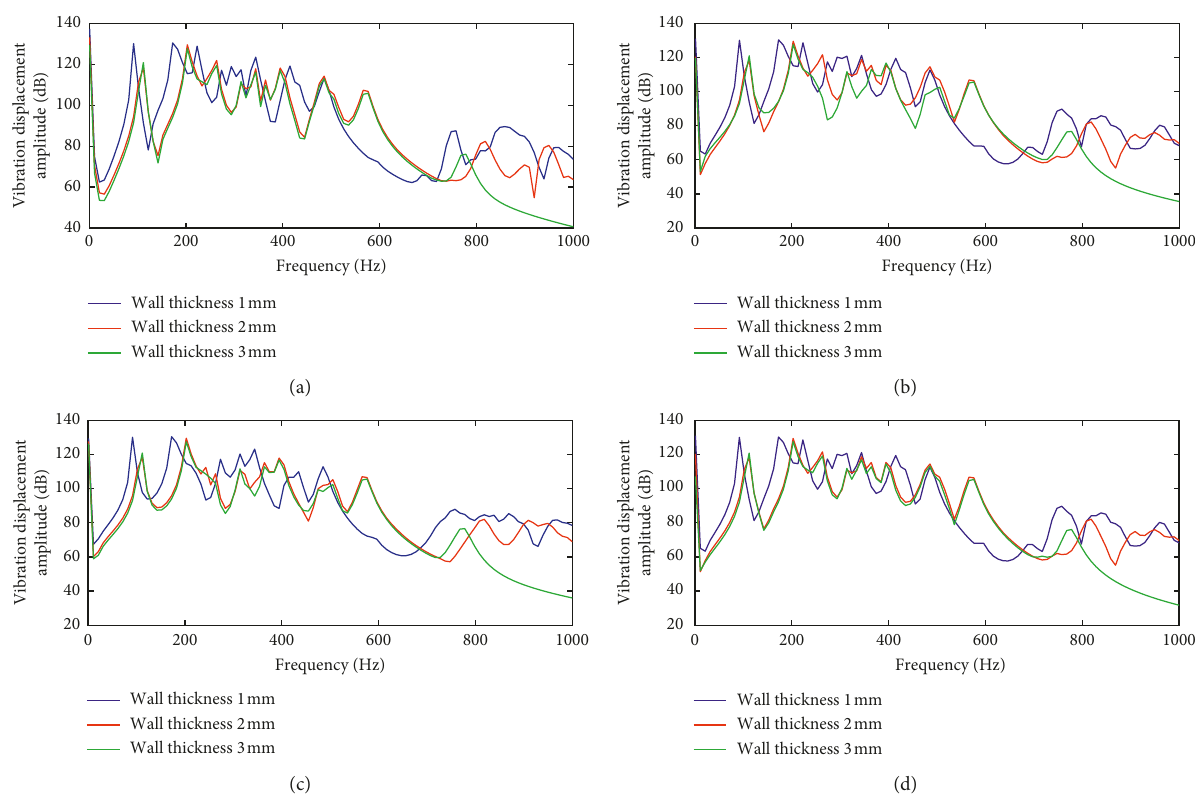
F IGURE 4: Harmonic response curves at different wall thicknesses at measuring points (a) 1, (b) 2, (c) 3, and (d)